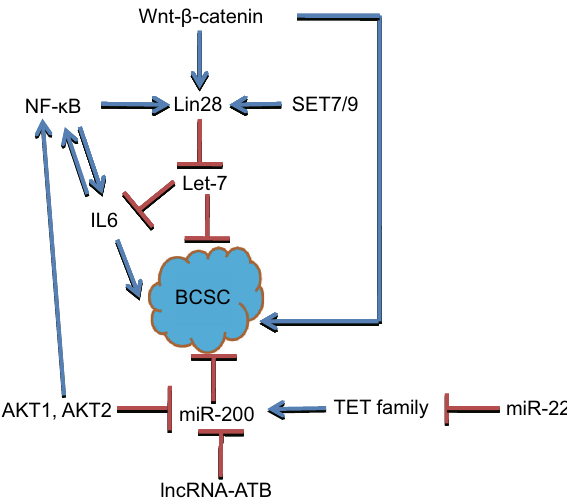
Figure 1. Let-7 and miR-200 inhibit BCSCs. Wnt- β -catenin could regulate BCSCs not only by regulating Lin28, but also by other proteins. Lin28 can be activated by NF- κ B and SET7/9. Lin28 inhibits let-7. AKT1 and AKT2 suppress miR-200, and also activate NF- κ B to regulate BCSCs. miR-22 inhibits TET family proteins which can activate miR-200, and lncRNA-ATB also inhibits